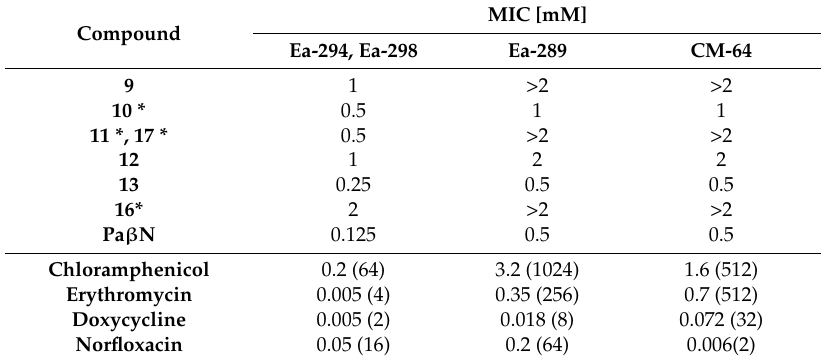
Table 4. MIC values obtained for compounds tested, PA β N and selected antibiotics against E. aerogenes . MIC [mM] Compound Ea-294, Ea-298 Ea-289 CM-64 1